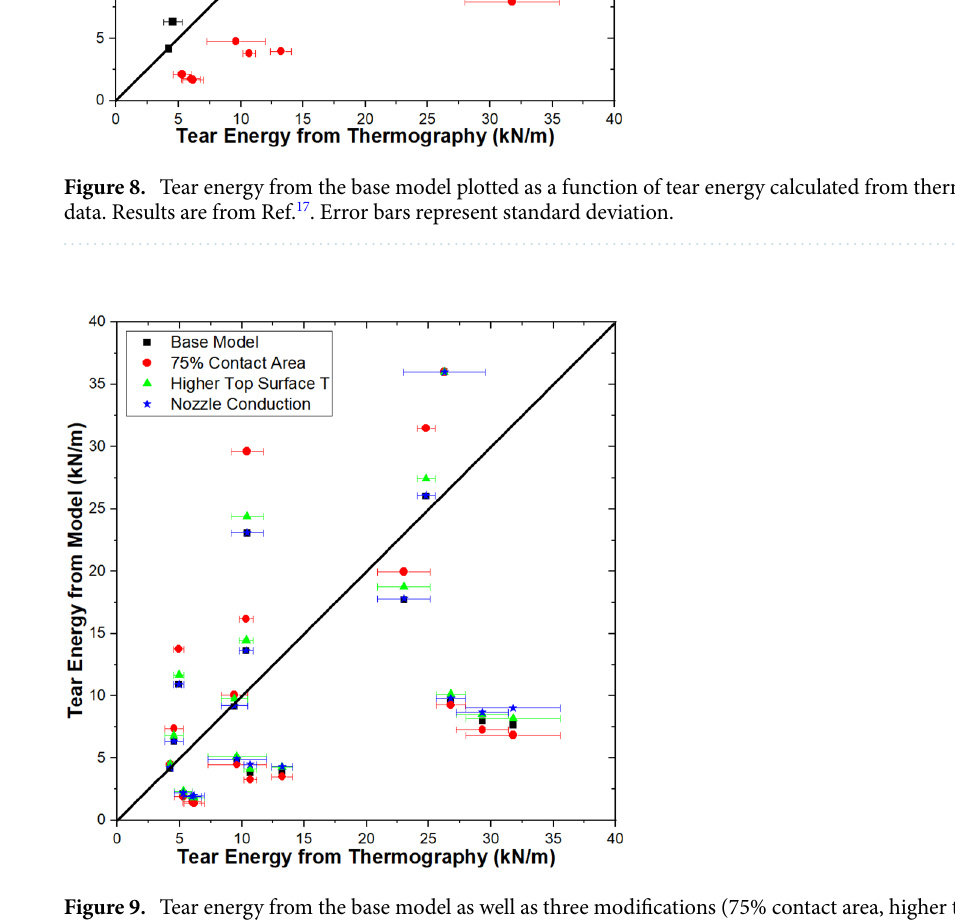
Figure 9. Tear energy from the base model as well as three modifications (75% contact area, higher top surface temperature, and accounting for nozzle conduction) plotted as a function of tear energy calculated from thermography data. Thermography data are from Ref. 17 . Error bars represent standard